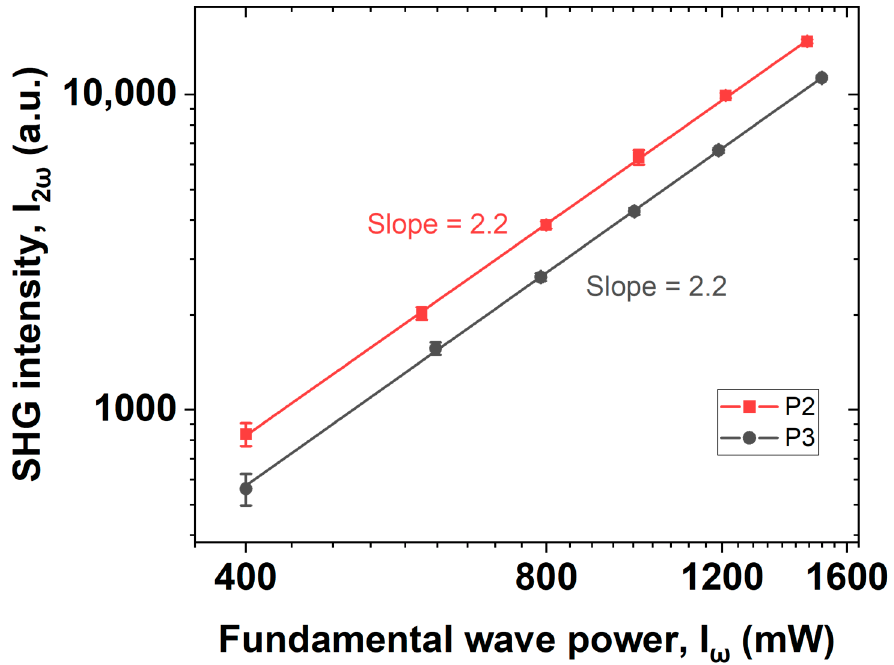
Figure 7. Second harmonic intensity depends quadratically on the fundamental wave power.